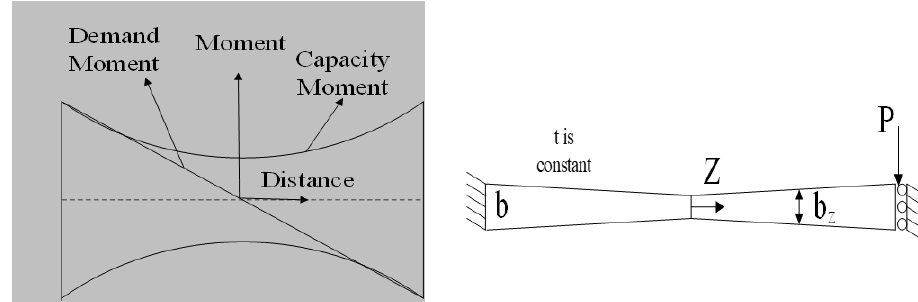
Figure 3. The butterfly shaped shear fuse loading condition.